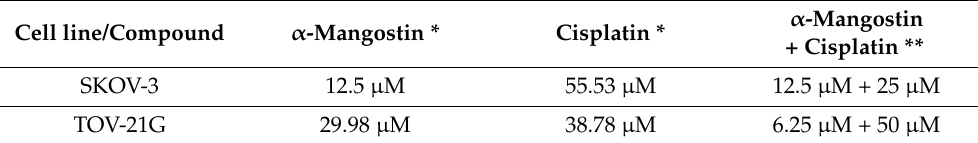
Table 3. α -Mangostin and/or cisplatin concentrations used to treat SKOV-3 and TOV-21G cells. Cell